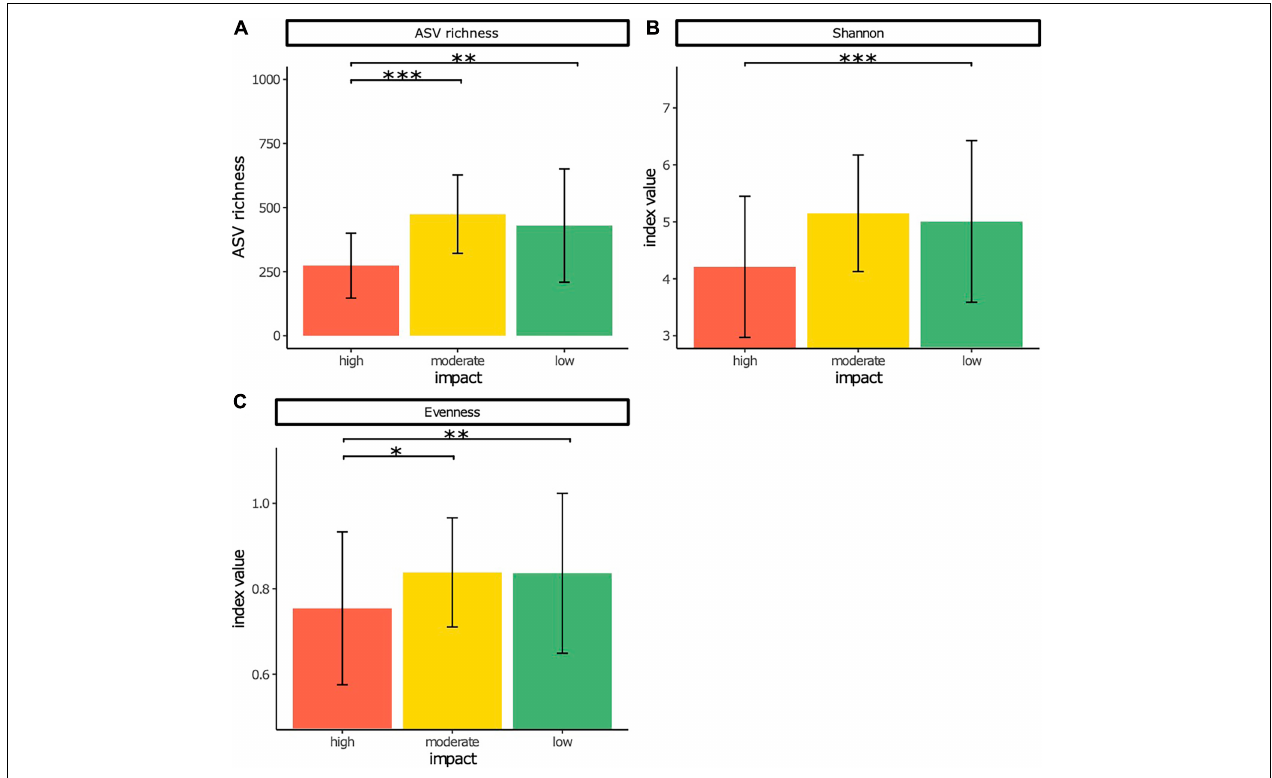
FIGURE 1 | Rarefied amplicon sequence variant (ASV) richness (A) , Shannon diversity (B) , and Pielou’s evenness (C) as measures of alpha diversity of bacterial communities in sediment samples from high, low, and moderate salmon aquaculture-related impact. Significant differences are indicated by * (* p < 0.05, ** p < 0.01, *** p < 0.001).